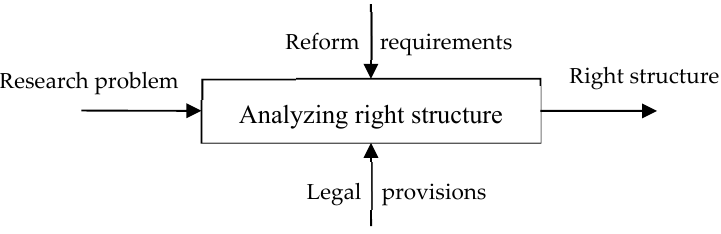
Figure 3. Inputs and output in the analysis process of the rights structure.